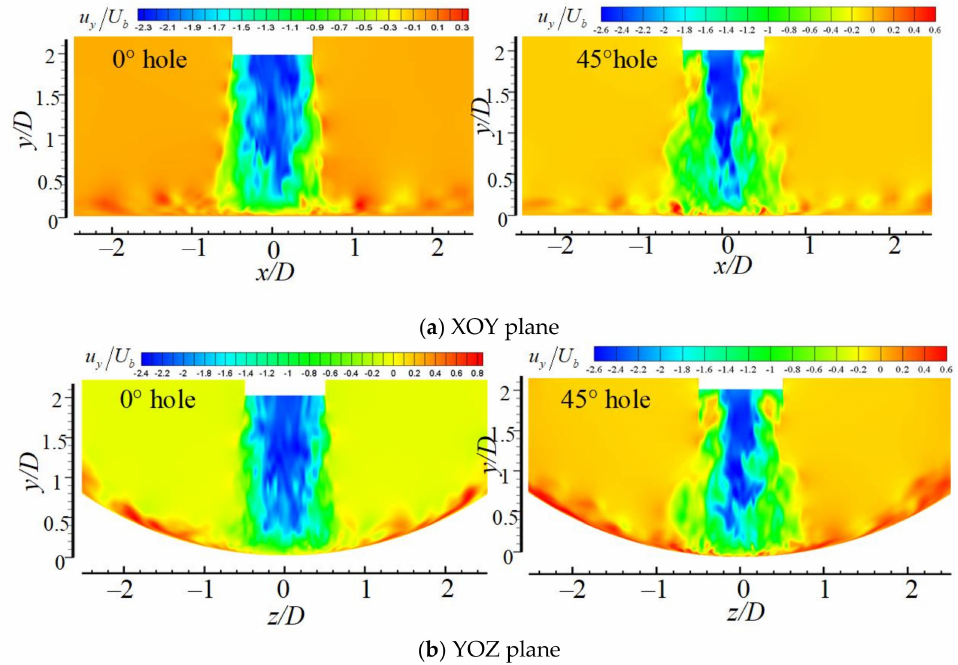
Figure 6. The contours of the instantaneous axial velocity in the XOY and YOZ planes.